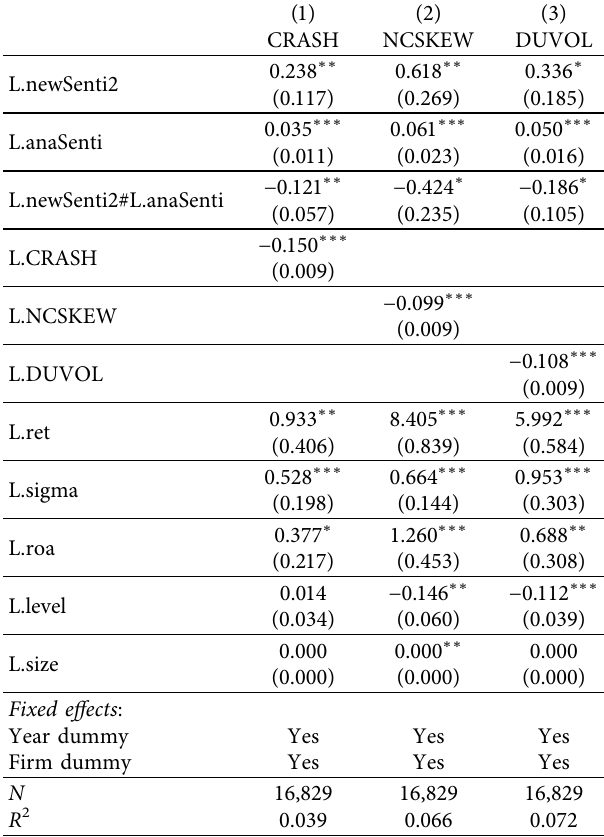
Table 23: Robust test: regression of adding analyst and media coverage sentiment